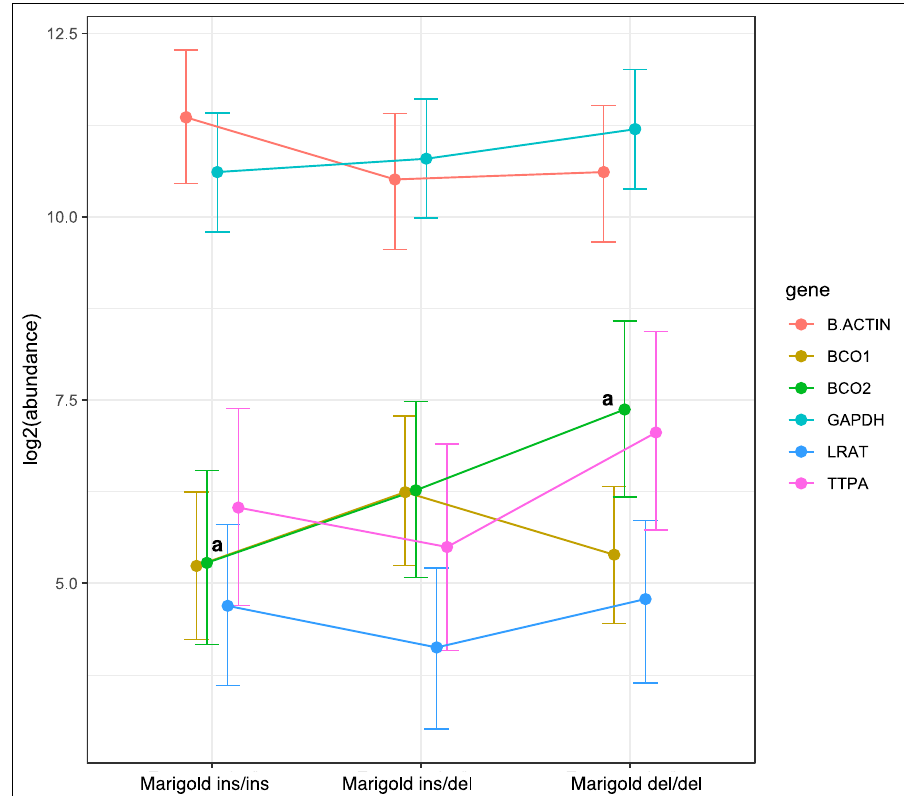
Figure 2. Relative BCO1 , BCO2 , LRAT , and TTPA mRNA levels in the liver of rabbits with different genotypes at codon 248 of the BCO2 gene (ins/ins vs. ins/del vs. del/del) fed a diet with the addition of Aztec marigold flower extract. GAPDH and β -actin were used as reference genes. Data represent posterior means (expressed as arbitrary units) ± 95% credible intervals. Means followed by the same superscripts (a, a) differ significantly ( p ≤ 0.05).